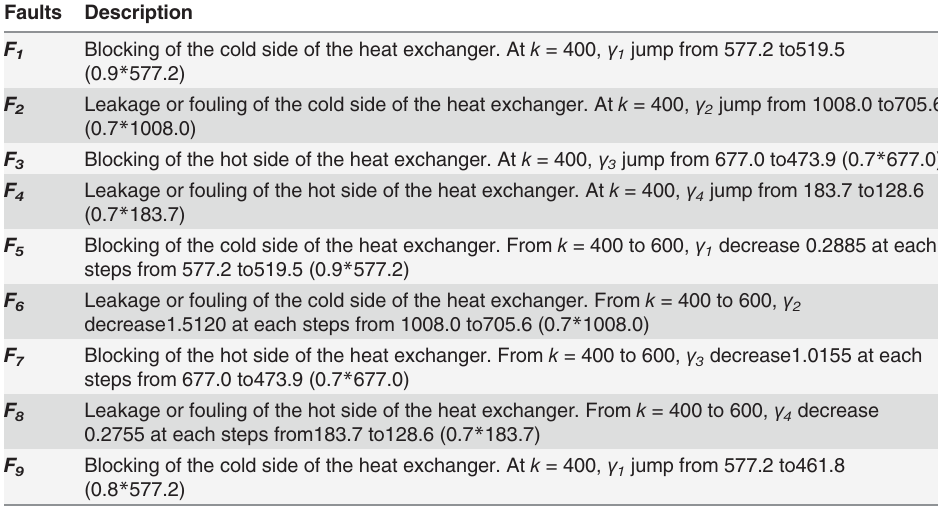
S1 and S2 Figs. It is illustrated that the initial values of the STF algorithm and the parameters of the MB algorithm have been selected well. Nine kinds of heat exchanger faults were tested. The faults are summarized in Table 3. The first four faults are abrupt faults, and “ F